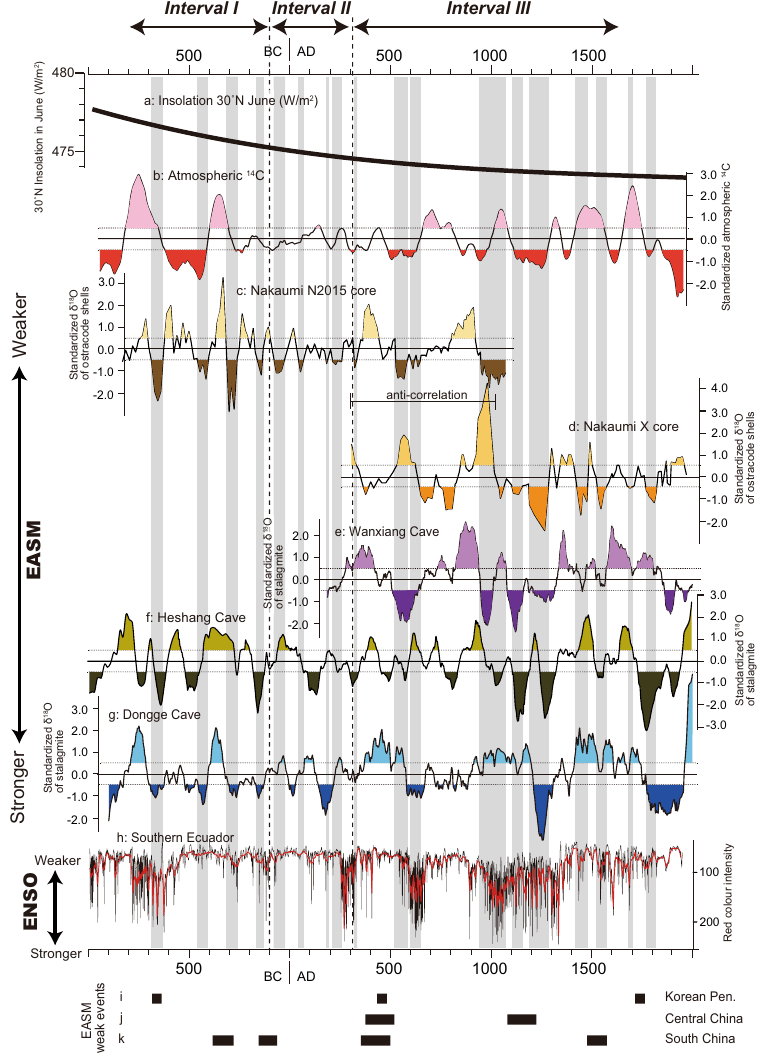
Figure 3. Comparisons of EASM records in the monsoonal region, sun activity and climatic records. ( a ) Insolation at 30°N in June 49 . ( b ) Standardized cosmogenic atmospheric 14 C 23 . ( c ) Standardized δ 18 O records in ostracode shells of Bicornucythere bisanensis from the N2015 core in Lake Nakaumi, southwest Japan. ( d ) Standardized δ 18 O in ostracode shells of B . bisanensis from the X core in Lake Nakaumi, southwest Japan 19 . ( e ) Standardized δ 18 O records from stalagmites from Wanxiang Cave, central China 20 . ( f ) Standardized δ 18 O records from stalagmites from Heshang Cave, central China 13 . ( g ) Standardized δ 18 O records from stalagmites from Dongge Cave, south China 4 . ( h ) Red colour intensity from the lake in southern Ecuador 36 . ( i – k ) weak EASM events identified in the millennial-scale EASM records from Baeg-nyong Cave, Korean Peninsula 25 , Tibetan Plateau, central China 5 , and Dongge Cave, south China 7 . Vertical grey bars indicate enhanced EASM periods from the records in Lake